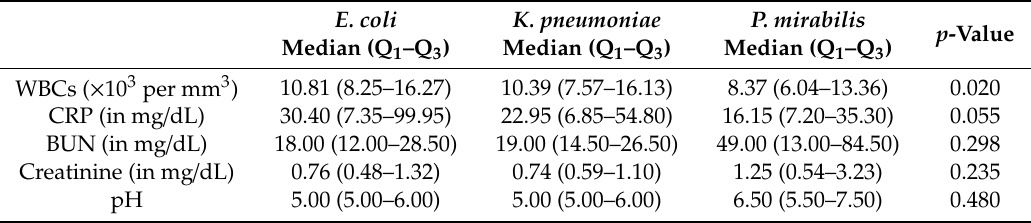
Table 4. Laboratory data related to each of the three studied uropathogens. Jonckheere–Terpstra test was used to compare the medians of the laboratory data of patients among the three uropathogen groups ( E. coli , K. pneumoniae , and P. mirabilis ). The level of statistical significance was set at p < 0.05.